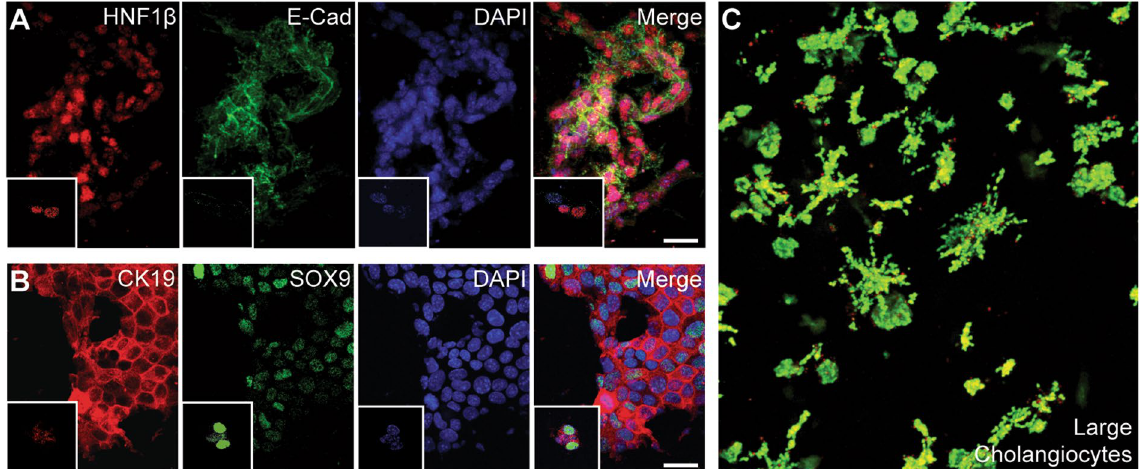
Figure 4. Cholangiocyte Phenotype is Essential for Duct Formation. ( A ) Duct-like structures formed by small cholangiocytes express HNF1 β , indicative of intrahepatic cholangiocytes after 7 days in culture. ( B ) Cells also express SOX9 and CK19, definitive indication that the cholangiocyte phenotype is maintained after 7 days. Insets in ( A ) and ( B ) show staining after 1 day in culture. ( C ) Confocal z-stack maximum intensity projection of live/dead stained large cholangiocytes (SV40LG) encapsulated within liver dECM, ducts do not form after 7 days. Scale bars = 25 μ